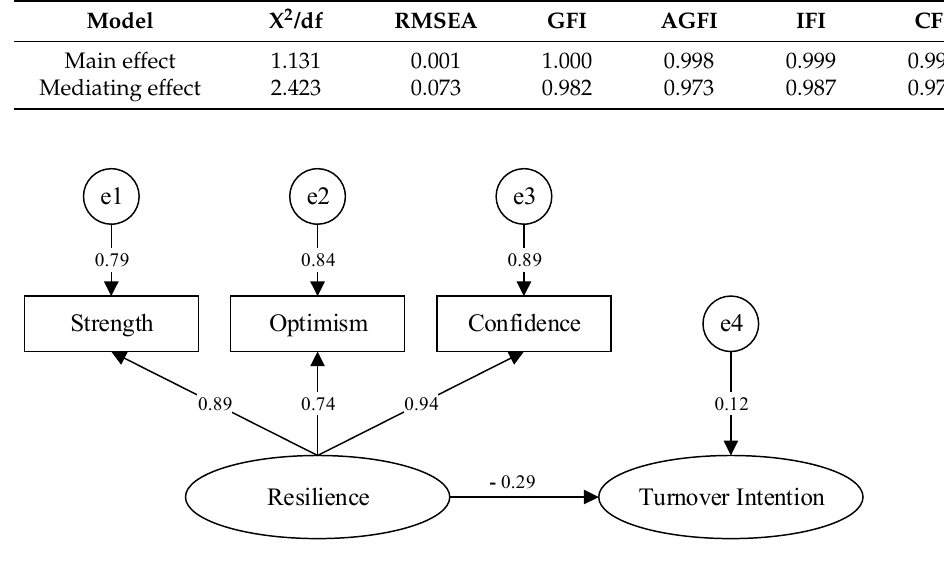
Figure 2. Direct effect model.